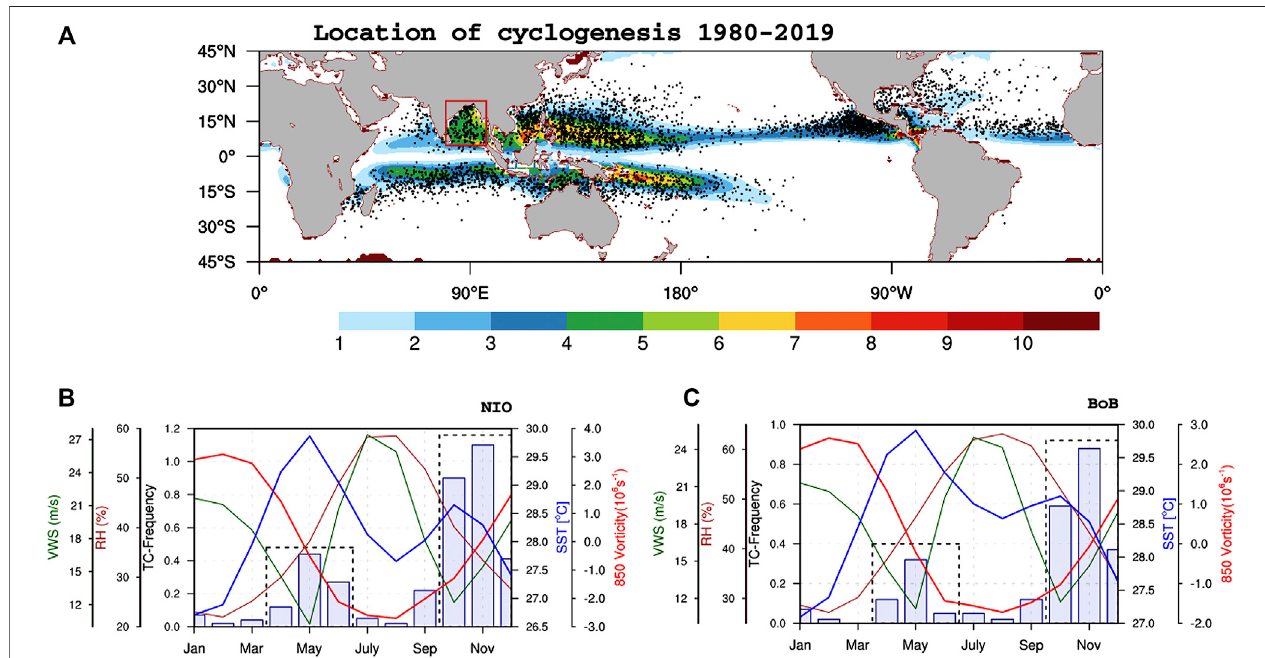
FIGURE 1 | Global TC genesis location (black dots) and climatology of Genesis Potential Index during 1980 – 2019 (A) ; red box indicates the selected study region (BoB).ClimatologyofSST(blue),verticalwindshear(green),vorticity(red),andrelativehumidityat600 hPa(brown)overtheNIO (B) andtheBoB (C) monthlydistribution of TC frequency (number per month) are indicated by bars and dashed boxes indicate the TC peak seasons.